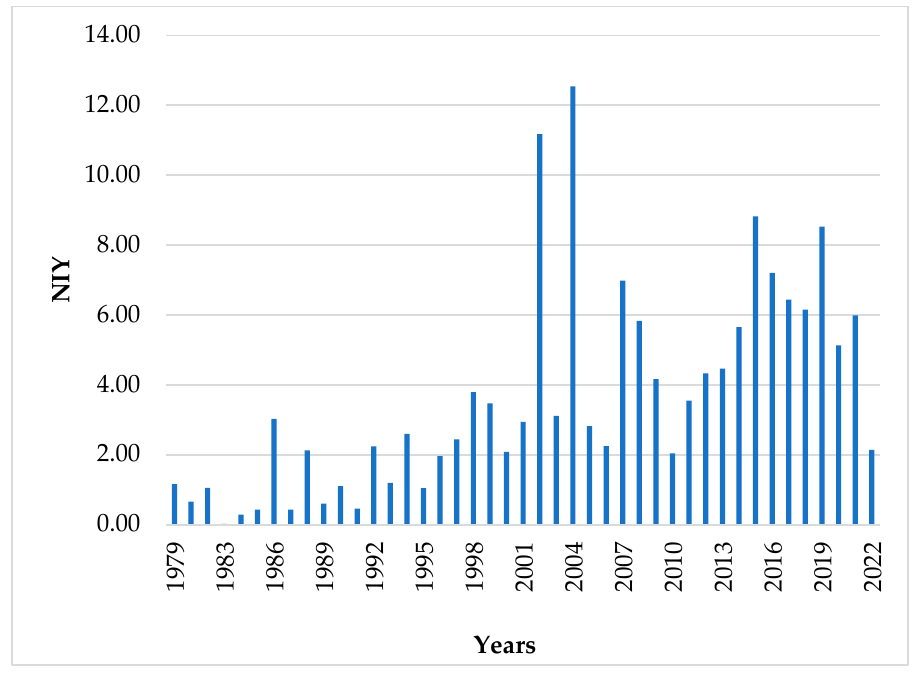
Figure 4. NIY detail analysis. Annual average.